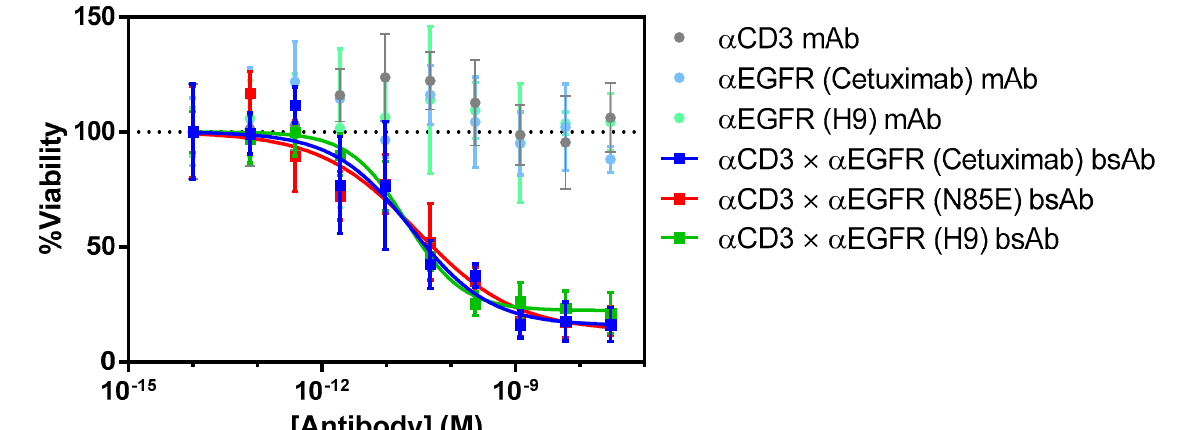
Figure 5. T cell-dependent cellular cytotoxicity (TDCC) assay carried out to assess the functionality of α CD3 × α EGFR bispecific antibodies using wild-type cetuximab, aglycosylated cetuximab (N85E), and humanized version H9 as the α EGFR arm. Luciferized EGFR-bearing BxPC3 target cells were incubated with activated T cells and antibody dilutions for 72 h before reading the luminescence signal representative of viable BxPC3 cells. EC50 values are shown in Table